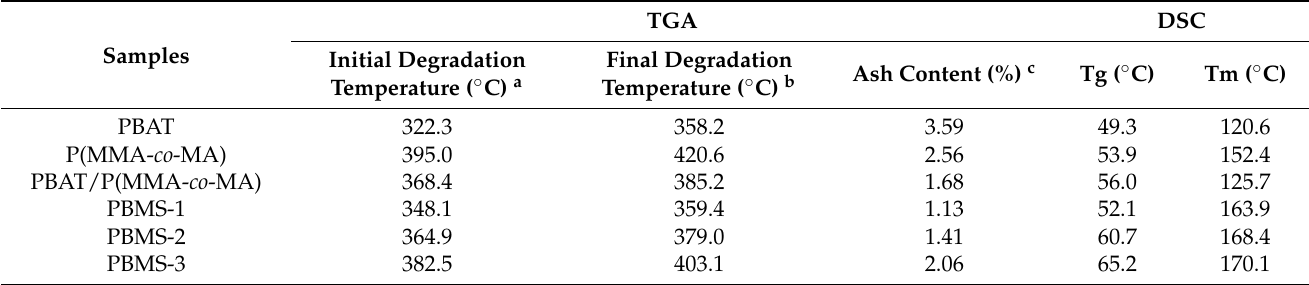
Figure 8. ( A ) TGA and ( B ) DSC curves of PBAT, P(MMA- co -MA), PBAT/P(MMA- co -MA), and PBAT/P(MMA- co -MA)–SiO 2 composites. Table 2. TGA and DSC results of PBAT/P(MMA- co -MA) blends and their composites.